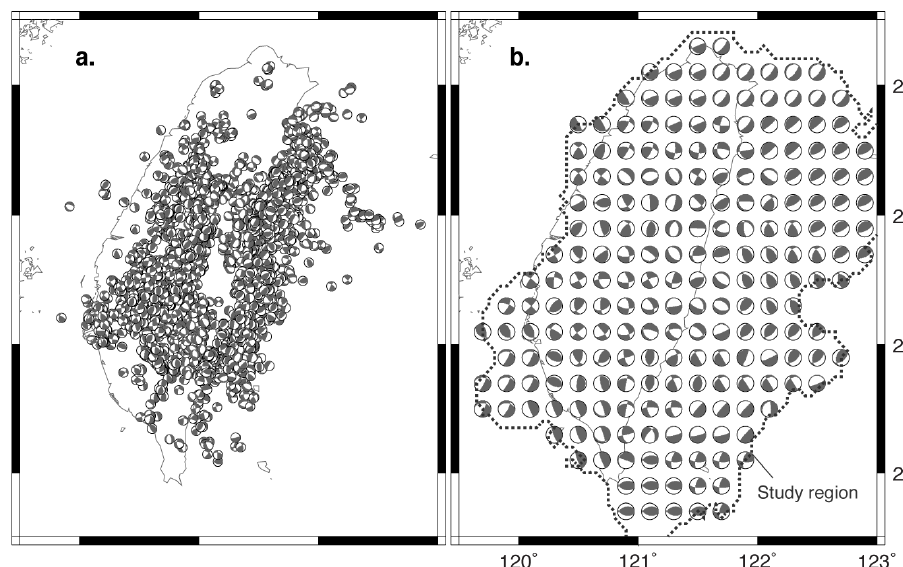
Fig. 1. (a) The focal mechanisms from 1991 until 2007 collected by Wu et al. (2010). (b) The focal mechanisms as receiver faults for the 1 CFS calculation. As shown in Fig. 2c, the dashed line illustrates the study